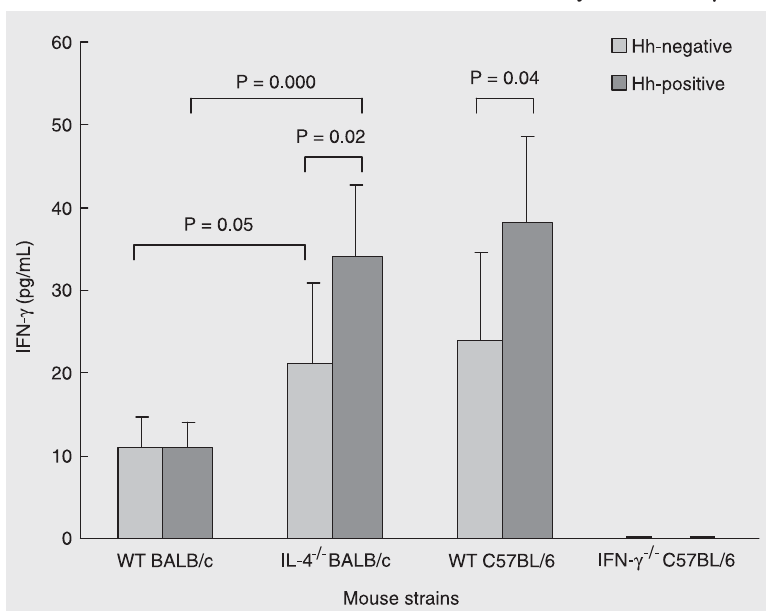
Figure 2. Serum IFN- γ levels in Helicobacter heilmannii -negative and -positive wild-type and knockout BALB/c and C57BL/6 mice. Hh = H. heilmannii ; WT = wild type; -/- = knockout; IFN = interferon; IL-4 = interleukin-4. P values are shown only when the differences were significant (Student t